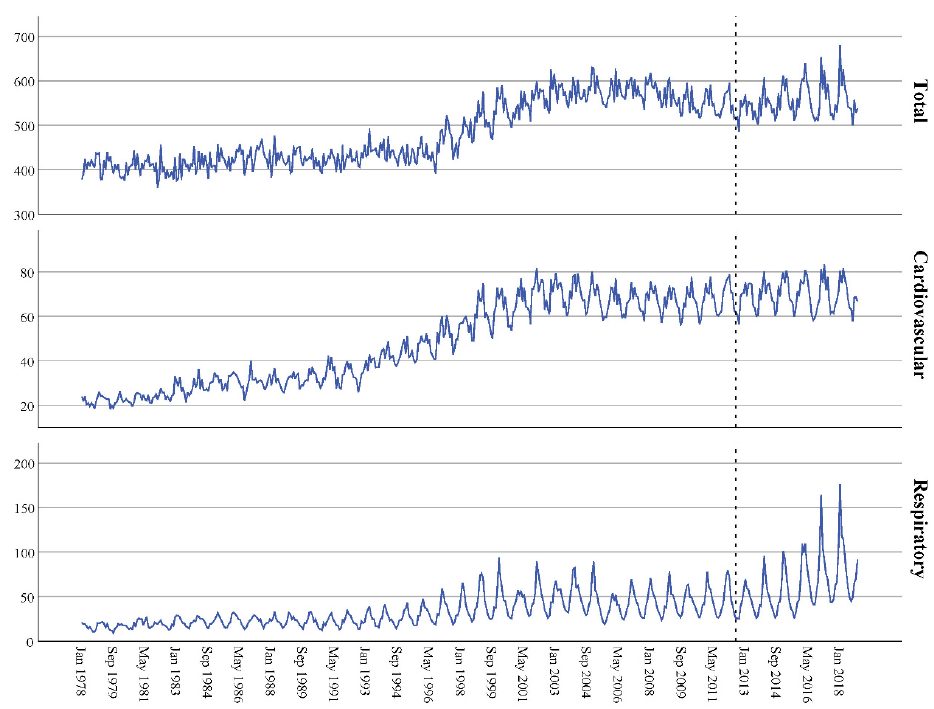
The dotted line indicates when the copayment system was implemented. The top figure corresponds to all-cause admissions, the middle figure to cardiovascular admissions and the bottom figure to respiratory admissions.